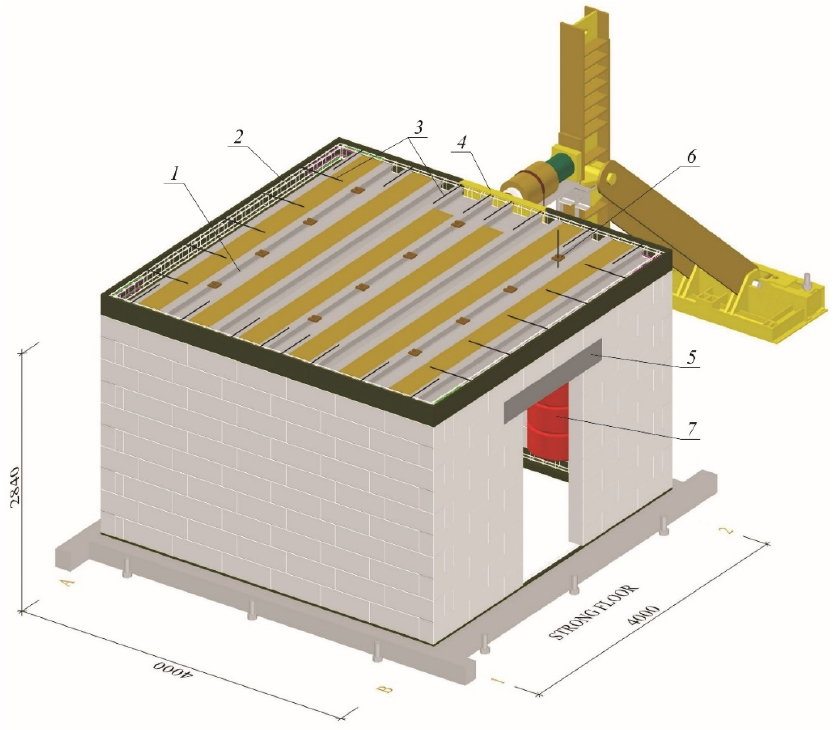
Figure 6. Research model in the test stand; 1 —prestressed precast slab panel; 2 —reinforcement of the top ring beam; 3 —top reinforcement of the slab; 4 —steel C-profile; 5 —precast lintel; 6 —load suspension points; 7 —visible weights.